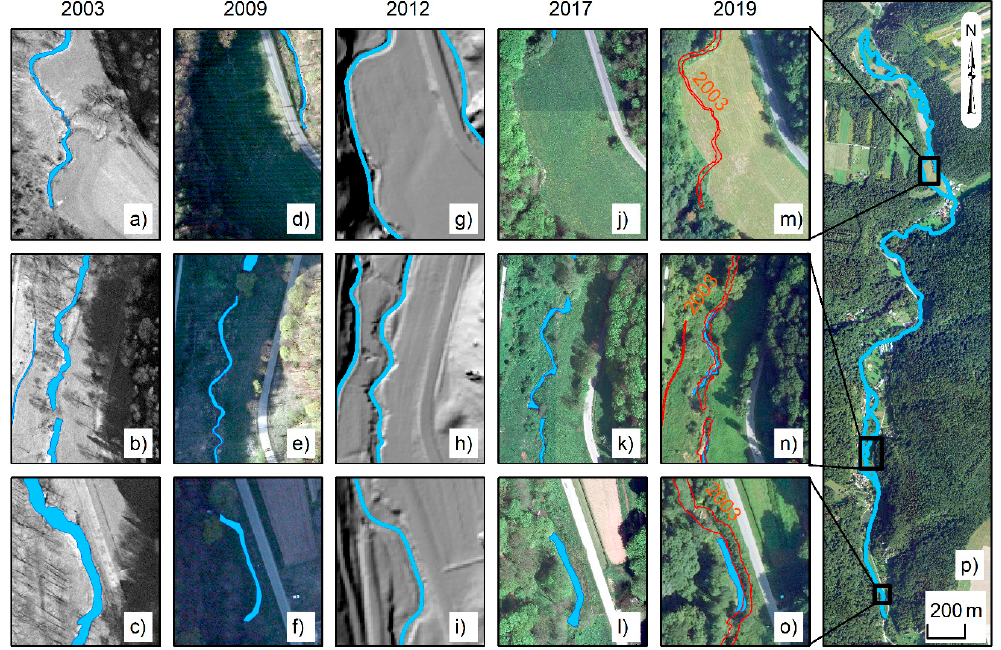
Figure 10. Di ff erences detected on the orthophotomaps. ( a , b , c )—orthophotomap Figure 10. Differences detected on the orthophotomaps. a, b, c —orthophotomap 2003; e, f, 2003; ( d , e , f )—orthophotomap 2009; ( g , h , i )—hillshaded DTM (ONP) 2012 and ONPw layer; g —orthophotomap 2009; g, h, i —hillshaded DTM (ONP) 2012 and ONPw layer; j, k, l — ( j , k , l )—orthophotomap 2017; ( m , n , o ) orthophotomap 2019; ( p )—orthophotomap 2019 and ONPw orthophotomap 2017; m, n, o orthophotomap 2019; p —orthophotomap 2019 and ONPw (2012) (2012) layer.